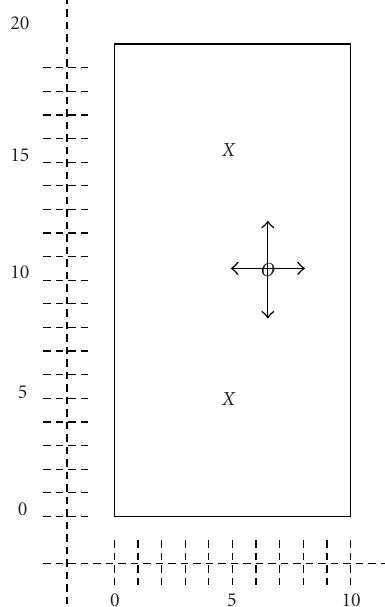
Figure 5: Simulated mean excess delay of channel using parameters in Table 1. (a) Omnidirectional. (b) w/ beam pattern.